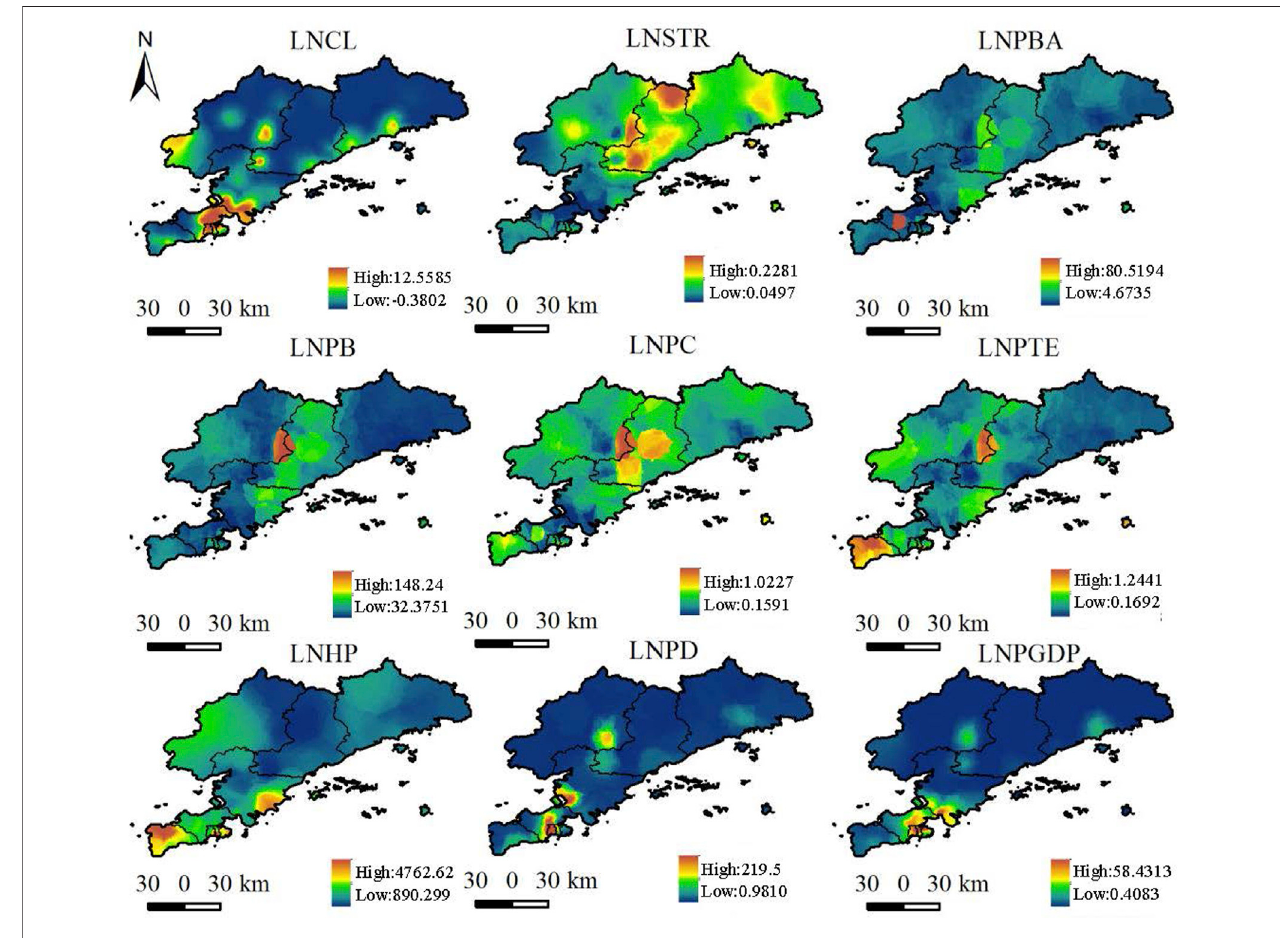
FIGURE 4 | Factors in fl uencing the number of migrant children in the spatial distribution.